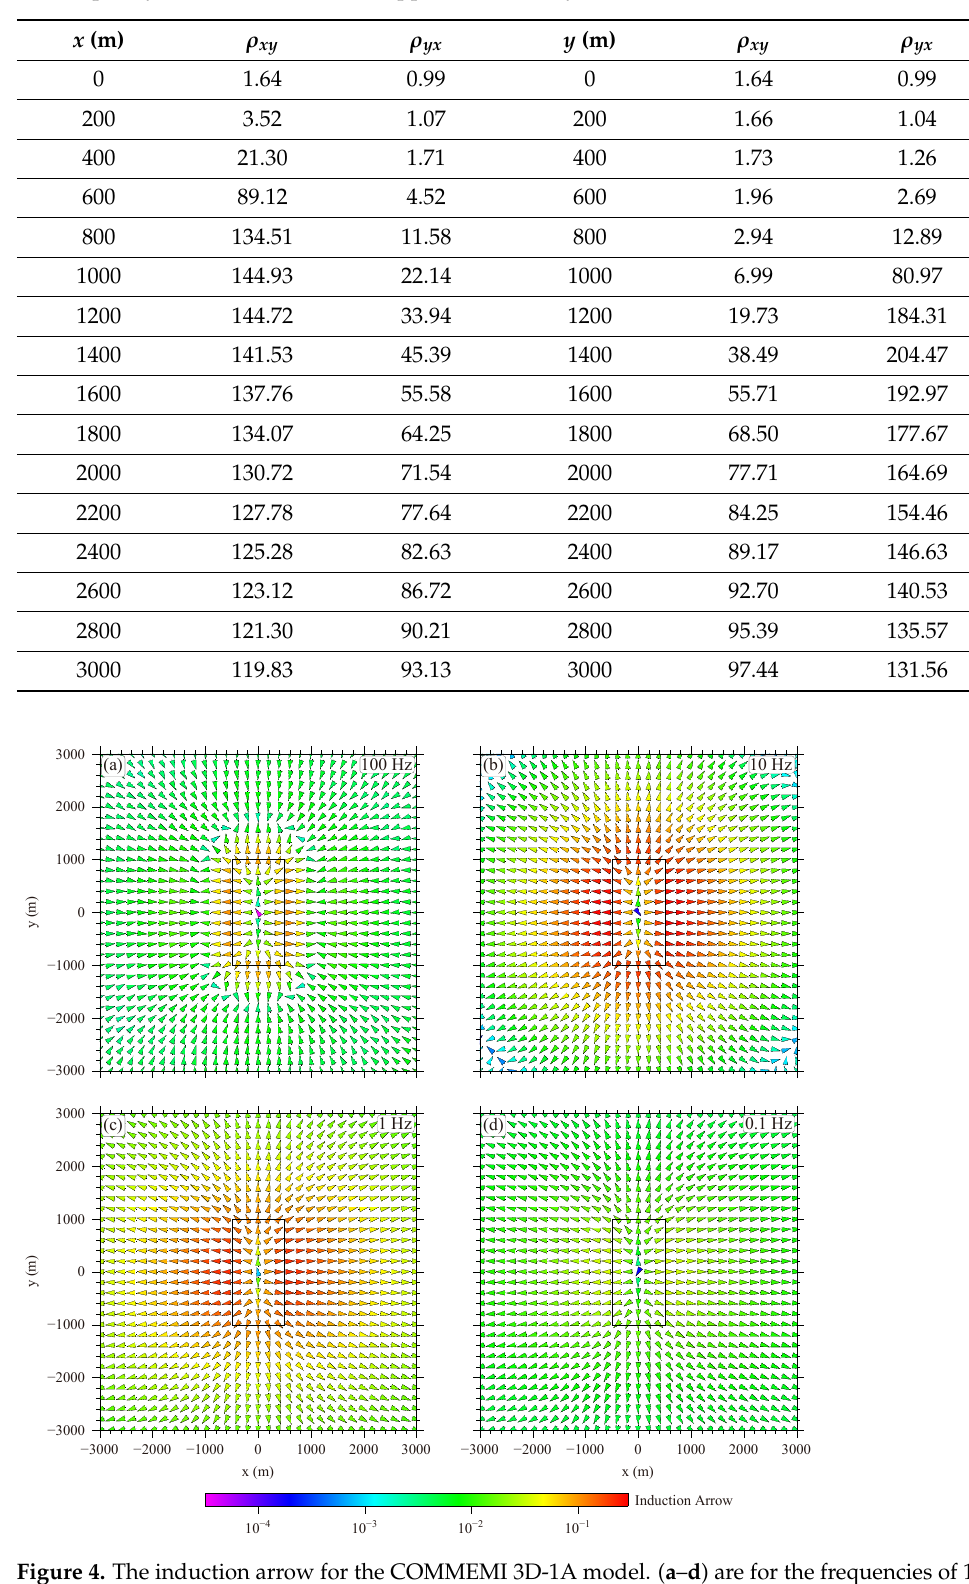
Table 1. The apparent resistivities calculated by the FE method for the COMMEMI 3D-1A model. The frequency was set to 0.1 Hz. The apparent resistivity unit is Ω m.